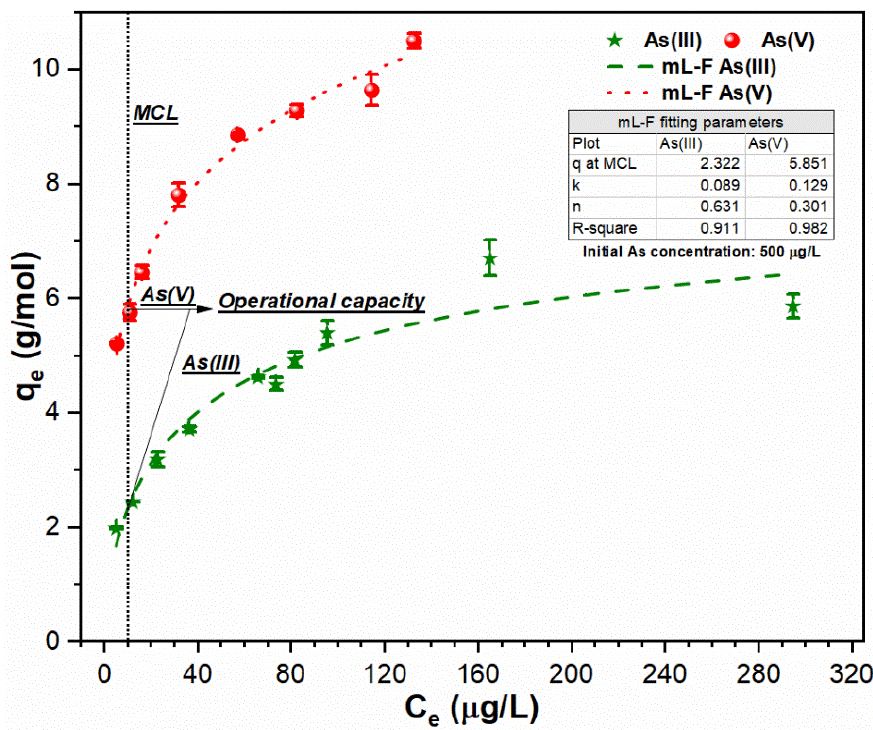
Figure 4. Sorption of As (III, V) species using mL-F model onto FHO surface at conditions: optimum pH of 7; temperature of 25 °C; FC dosage of (As (III): 0.035–0.25 mM; As (V): 0.035–0.095 mM); and initial As loading of 500 µg/L.